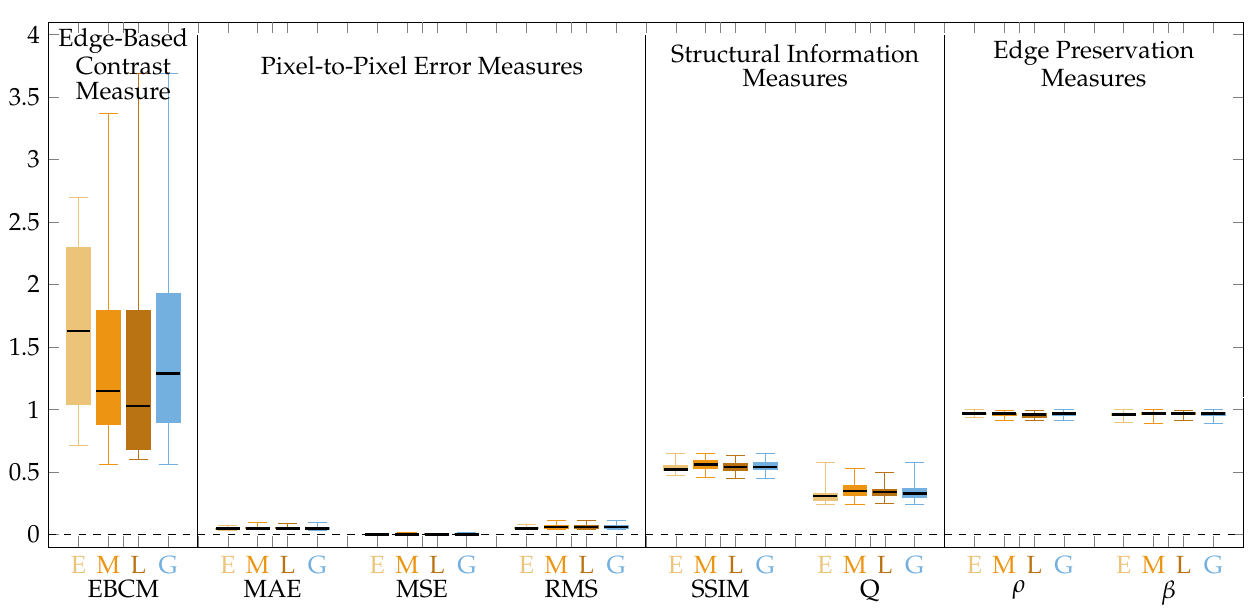
Figure 8. Quality measures for images processed by the CLAHE method. Measure values calculated for the peripheral image regions only.